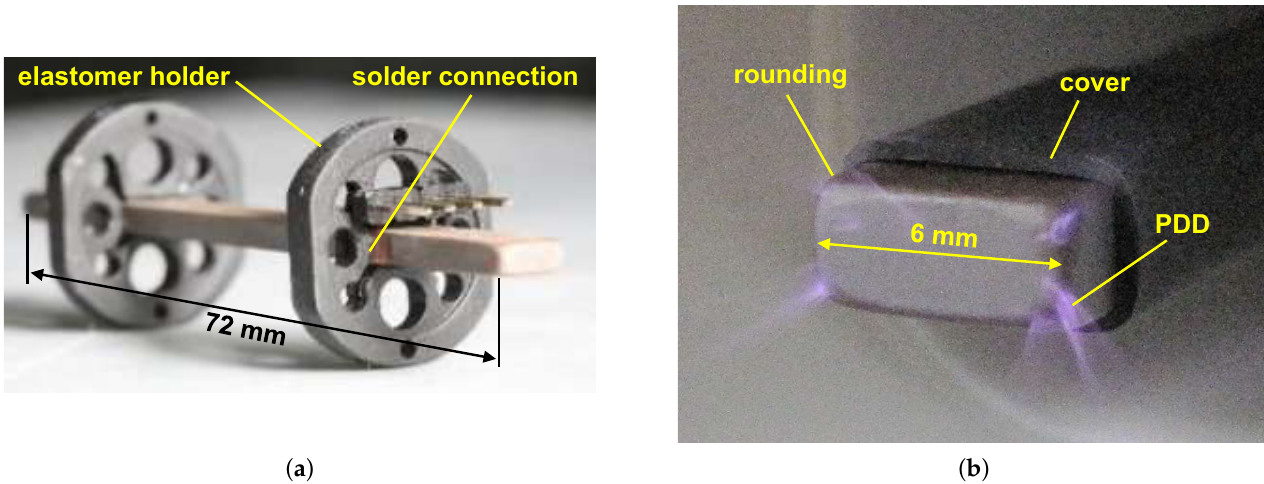
Figure 3. The PCPG mechanical features. ( a ) suspension of the PCPG prepared for assembling in the piezobrush ® PZ2 (courtesy of Relyon Plasma GmbH); ( b ) the PDD at the front face of the PCPG; and the features to suppress the parasitic discharges are